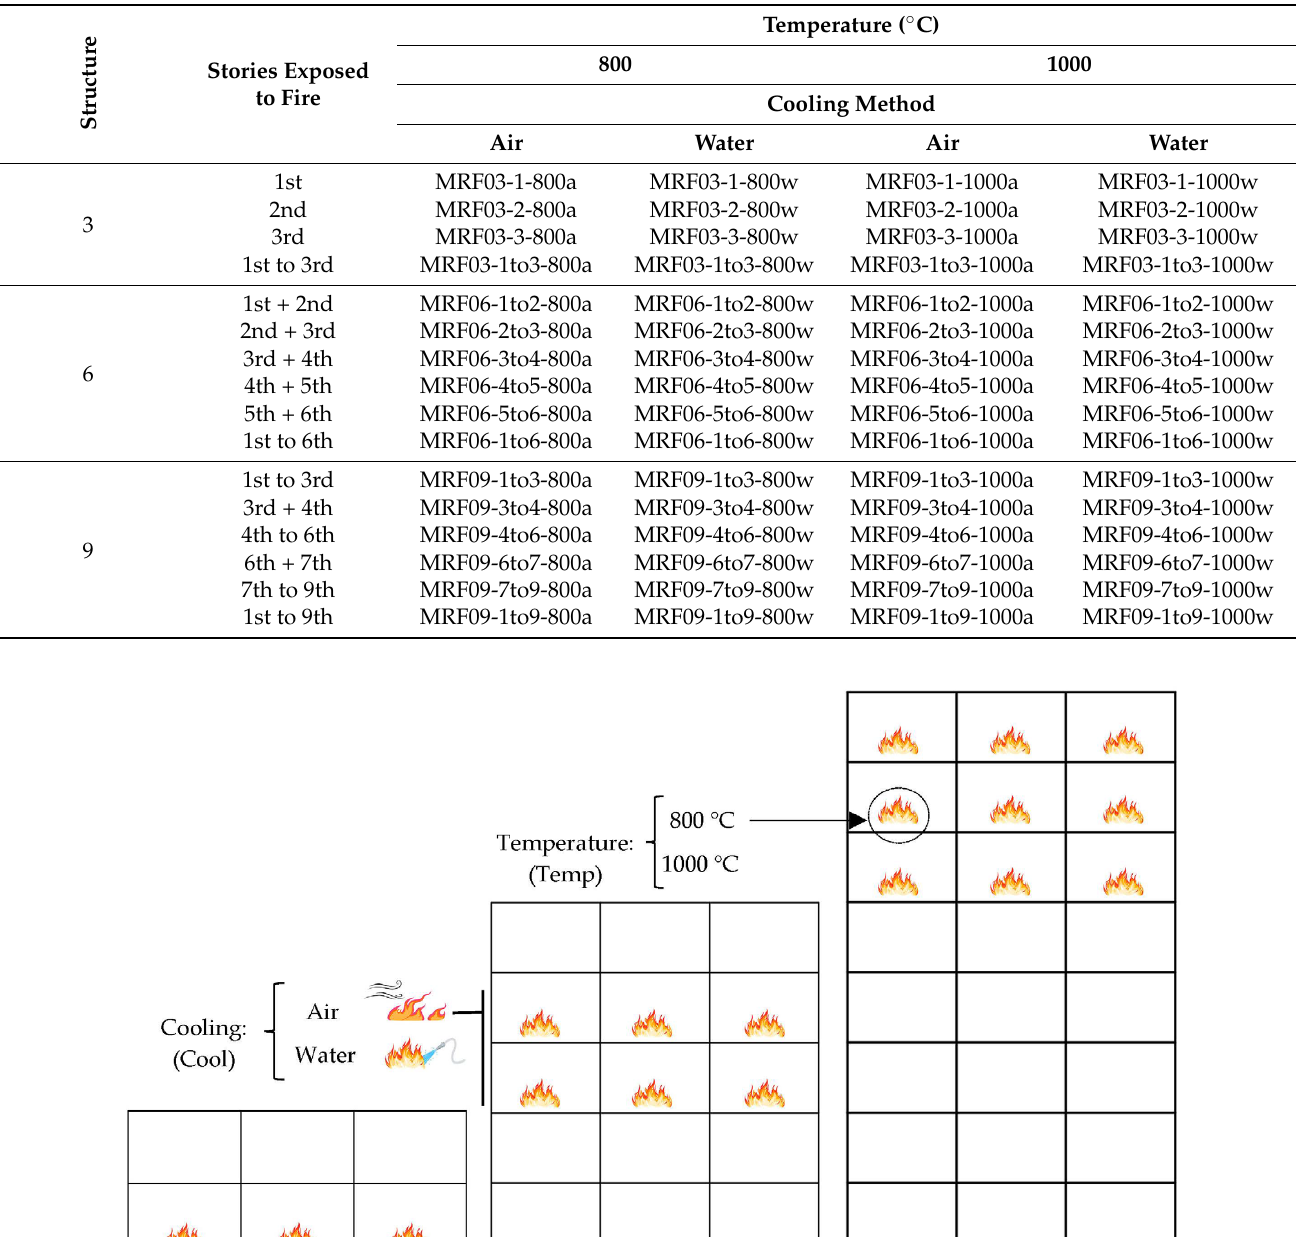
Table 2. Description of fire scenarios.